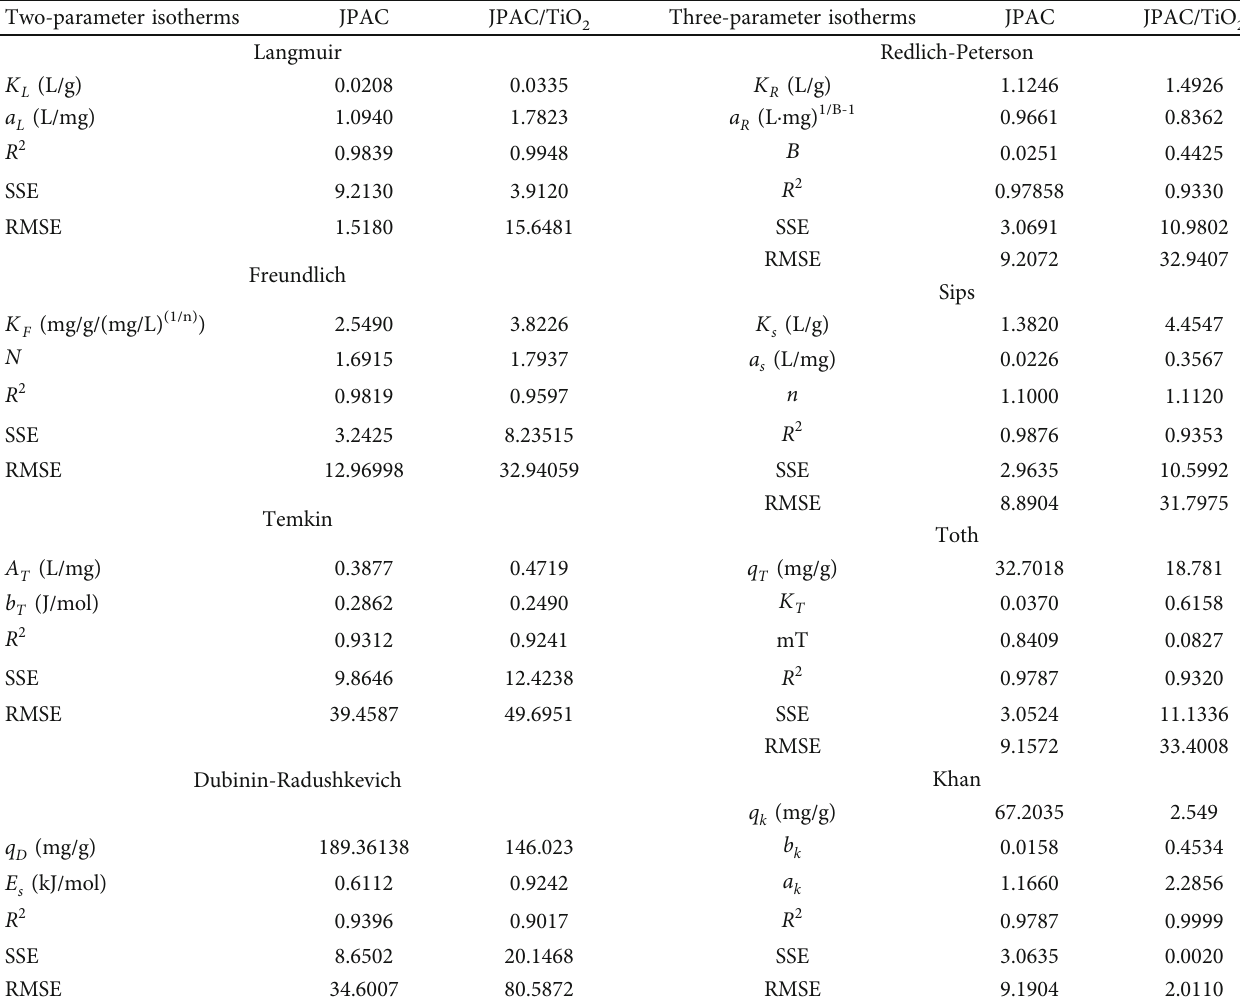
adsorption at di ff erent concentrations. 2 2